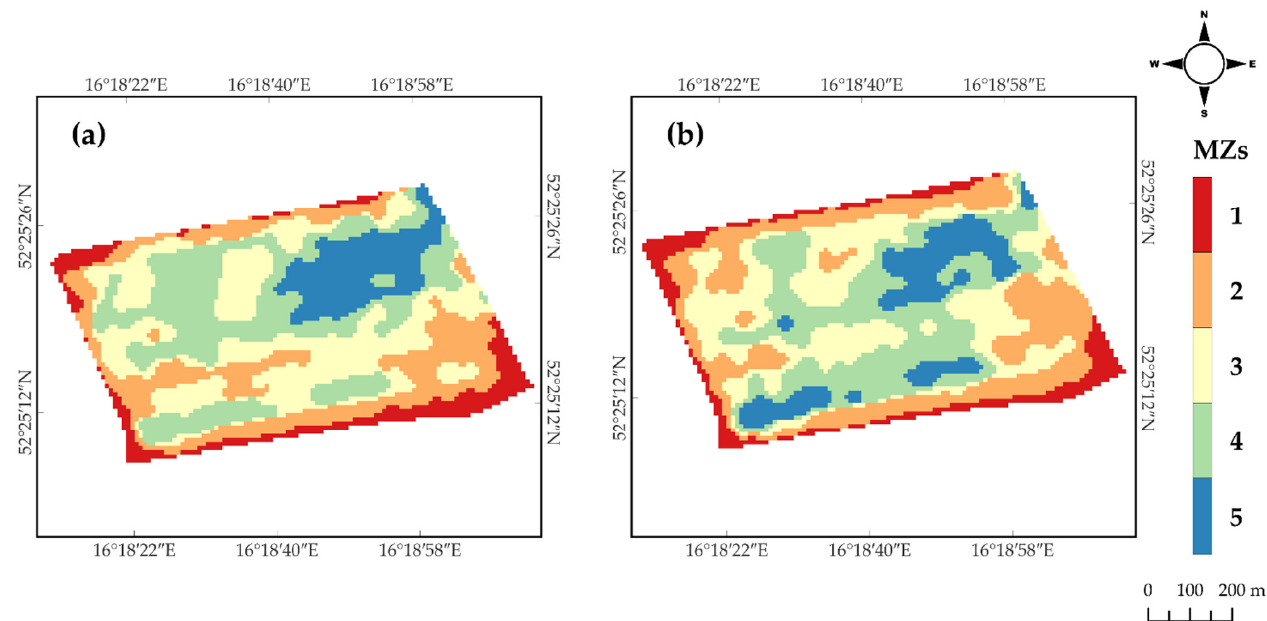
Figure 11. Delineated MZ maps of model-1 for fertilization at 25 March 2020 ( a ) and 21 April 2020 ( b ).